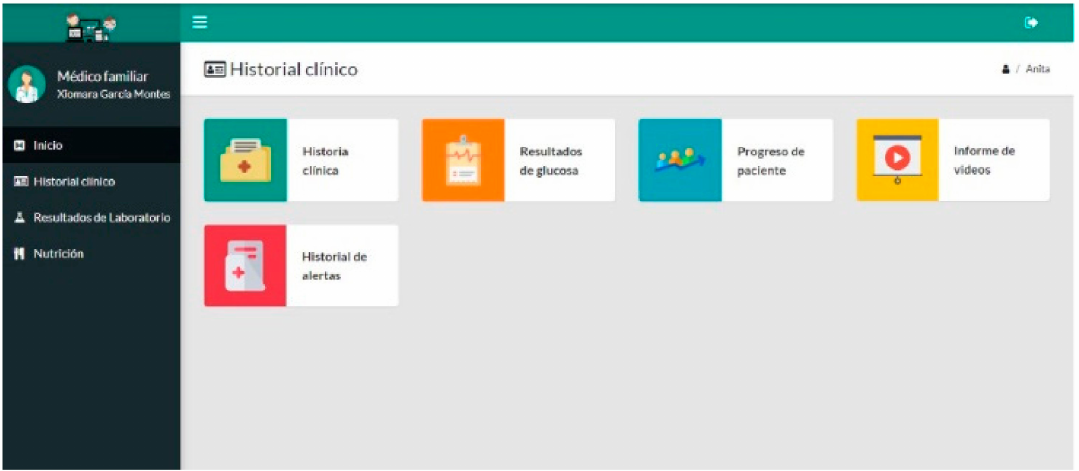
Figure 15. Physician application interface: Clinical history sub-modules, glucose results, patient treatment progress, video report, and report or alert